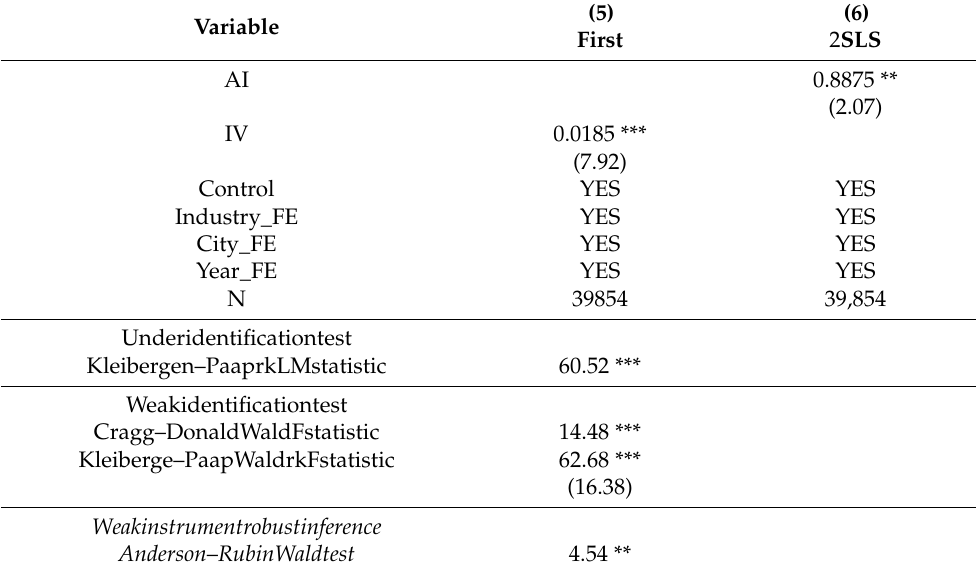
Table 4. Endogenous